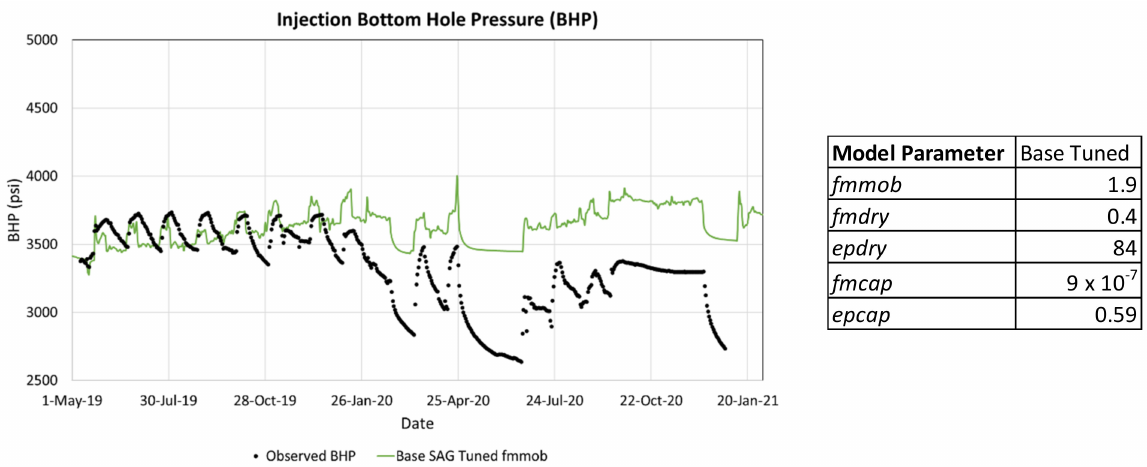
Figure 11. Injection bottom hole pressure (BHP) through time for the tuned base foam model (green curve). The observed BHP is shown as the black circles.